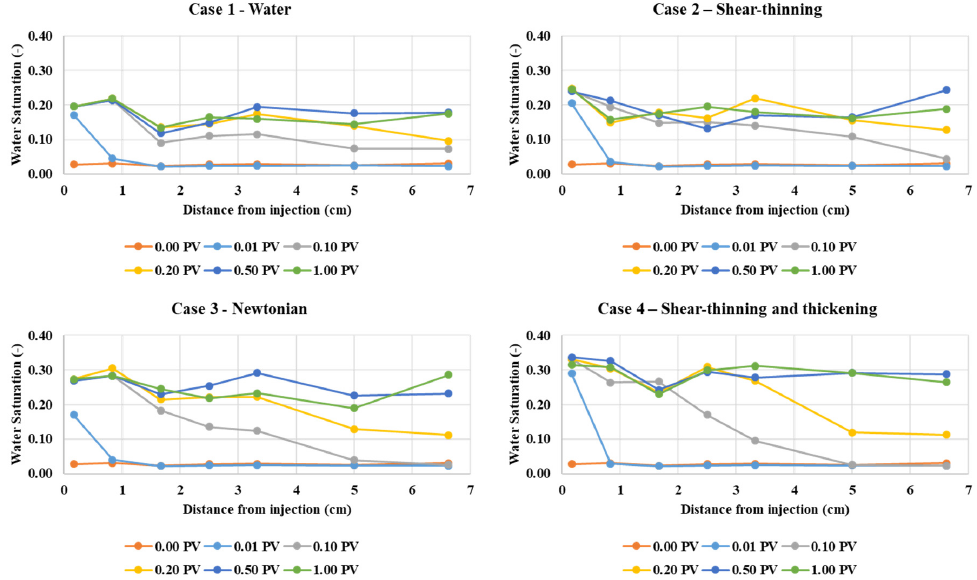
Figure 23. Water saturation as a function of distance from injection at different pore volumes injected for the longer (200 × 25) pore network model.